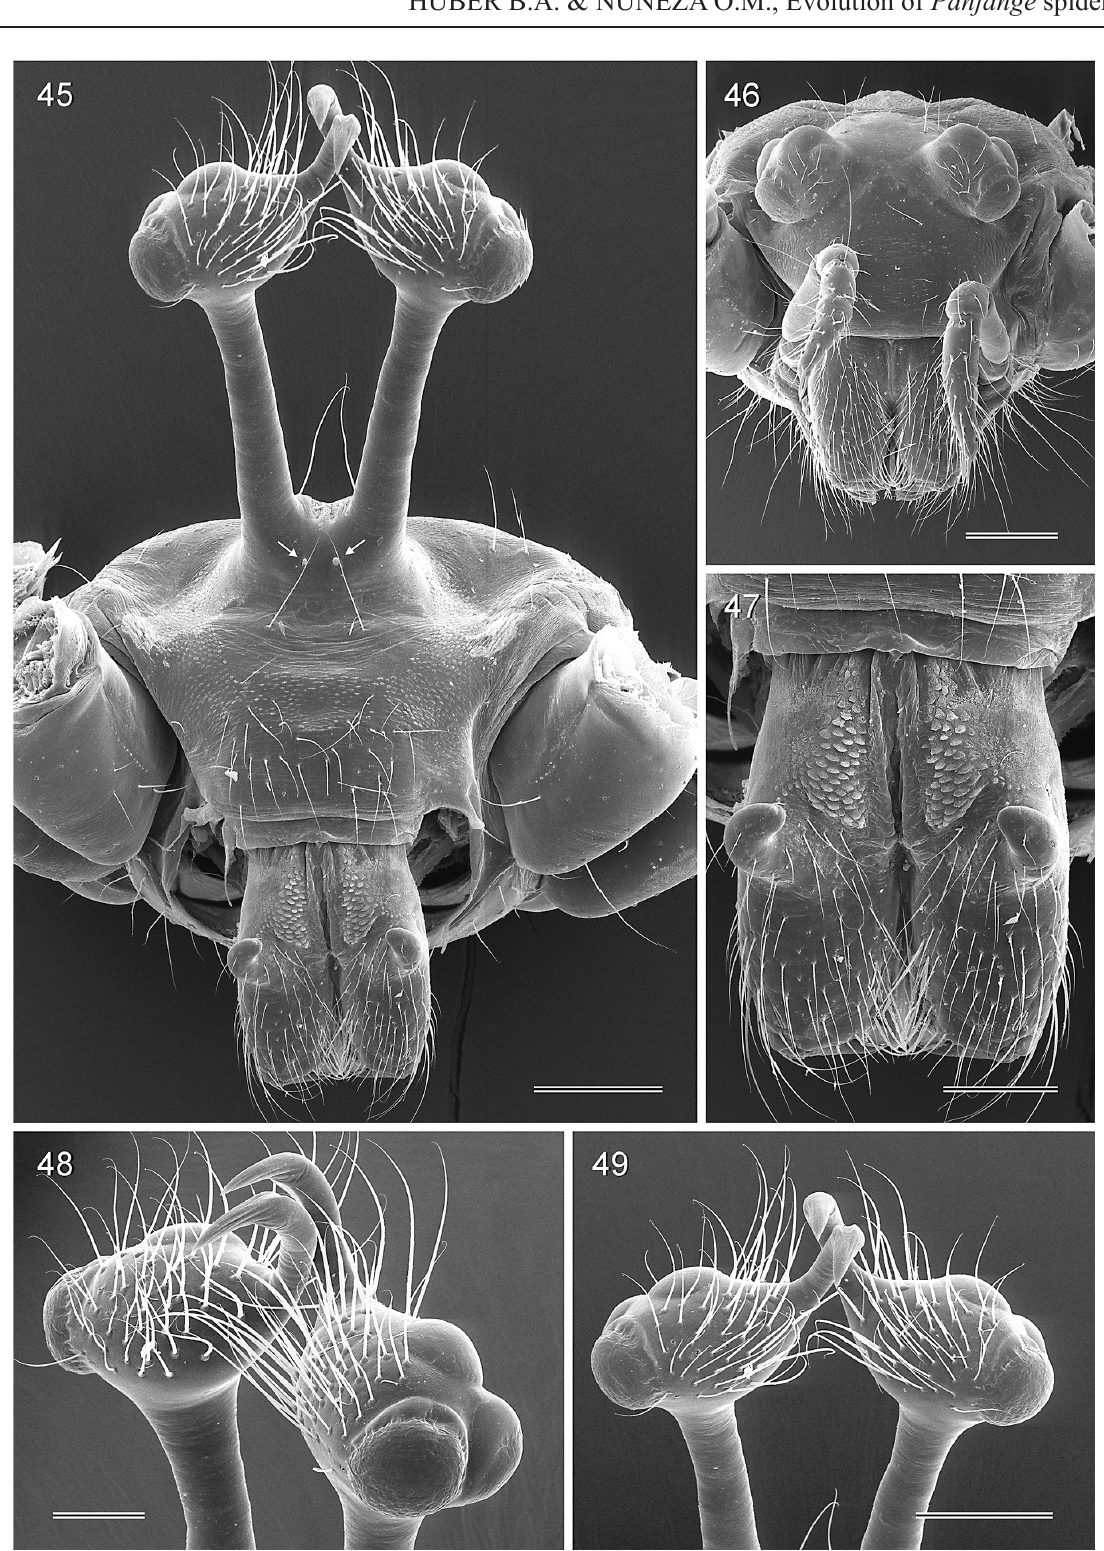
Figs 45–49. Panjange camiguin Huber sp. nov., SEM micrographs (ZFMK, Ar 13003, 13004). 45– 46 . Male and female prosomata, frontal views (arrows point at tiny AME remnants). 47 . Male chelicerae. 48–49 . Male eye triads and ocular processes, oblique frontal and frontal views. Scale bars: 45–46, 49 = 200 µm; 47–48 = 100